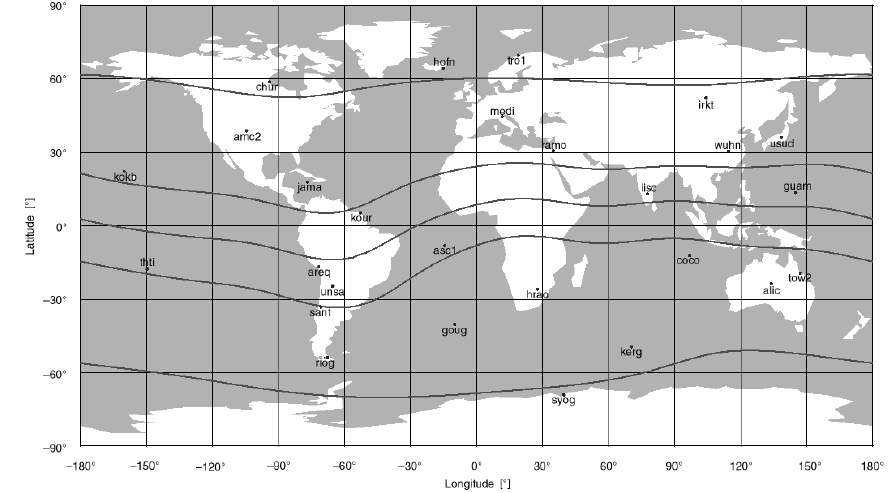
Fig. 3. Location of the IGS stations homogeneously distributed used to perform a concise analysis of the re- construction technique performances for the day 27 March 2000. Modip isolines at − 60°, − 30°, 0°, 30°, 60° are